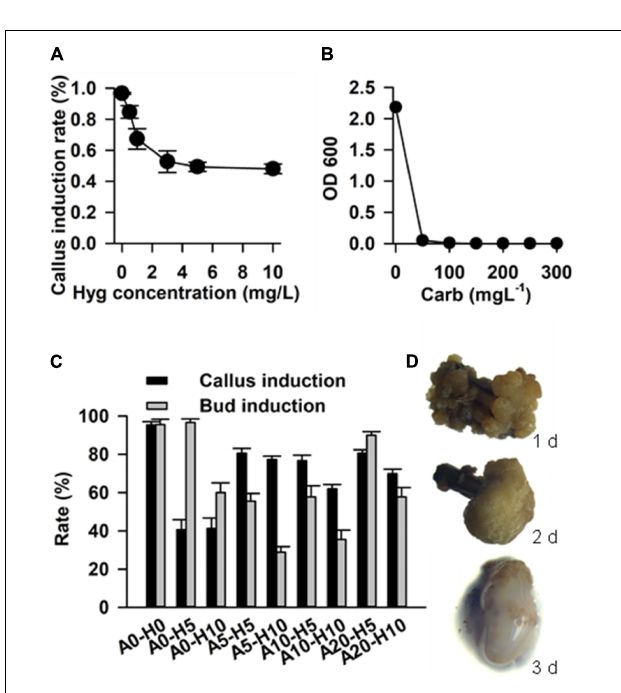
FIGURE 6 | Factors that affect transformation efficiency in Casuarina equisetifolia . (A) Hygromycin concentration for the selection of transformants. (B) Carbenicillin concentration for the inhibition of Agrobacterium . (C) Rate of callus and bud induction in the medium with different concentrations of acetosyringone (As) and hygromycin. The results are presented as the mean and standard error from three independent experiments. (D) Co-cultivation duration for transformation frequency. A0, A5, A10, and A20: concentration of As are 0, 5, 10, and 20 mg/L; H0, H5, and H10: concentration of hygromycin were 0, 5, and 10 mg/L.